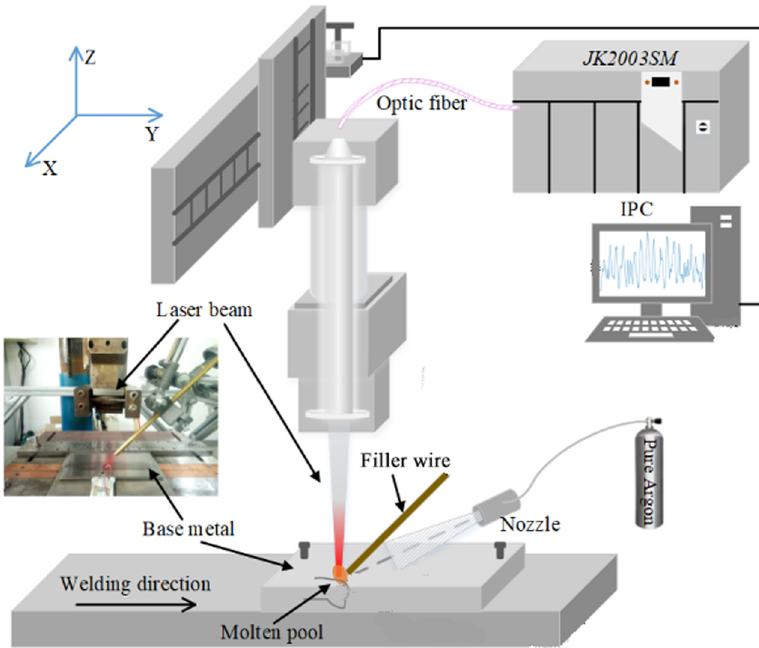
Figure 1: Schematic diagram of laser weld with fi ller